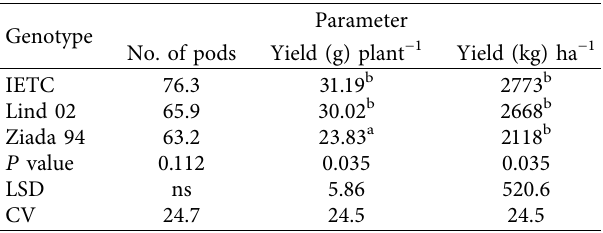
Table 5: The effect of different sesame varieties to vegetative and reproductive